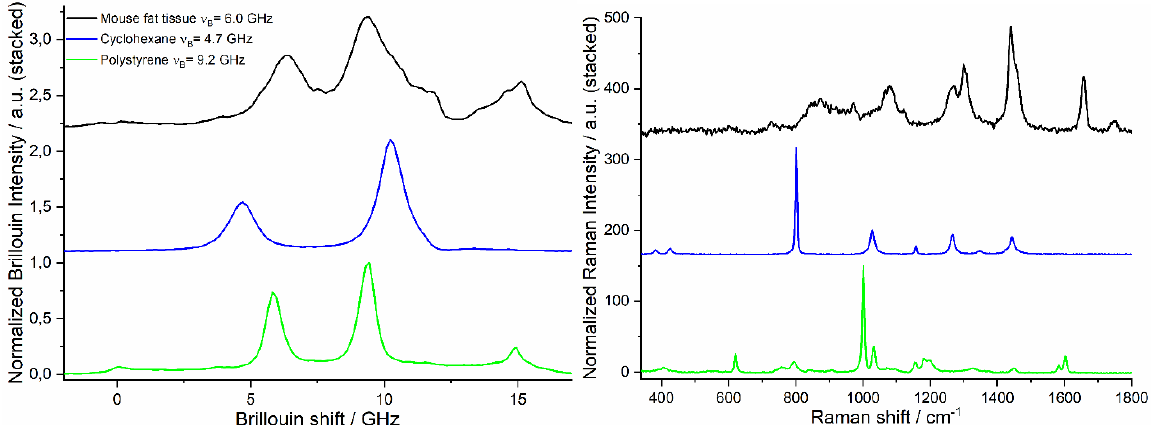
Fig. 2. Exemplary Brillouin and Raman spectra of polystyrene, cyclohexane and fat tissue of a mouse. Water has been used for axis calibration of the Brillouin spectra. As the free spectral range (FSR) of the VIPAs amounts 15 GHz, the Rayleigh bands appear at 0 GHz and 15 GHz, because of an incomplete filtering out of the elastically scattered